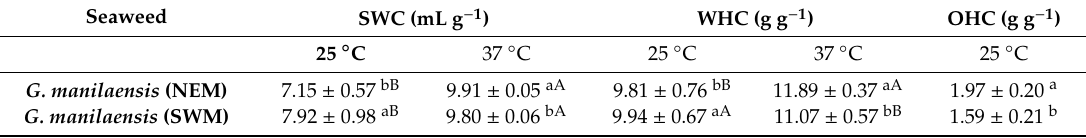
Table 6. Variation in The Physicochemical Properties of Edible G. manilaensis at 25 ◦ C and 37 ◦ C. Seaweed SWC (mL g − 1 ) WHC (g g − 1 ) OHC (g g − 1 ) 25 ◦ C 37 ◦ C 25 ◦